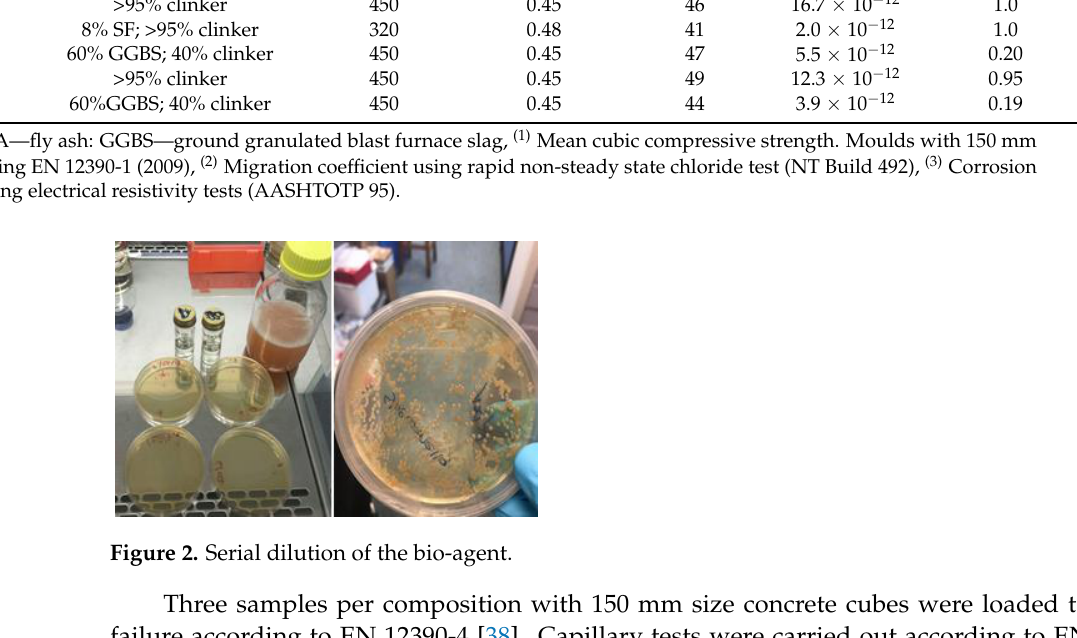
Table 1. Concrete compositions tested and test results at the age of 28 days. Concrete Composition